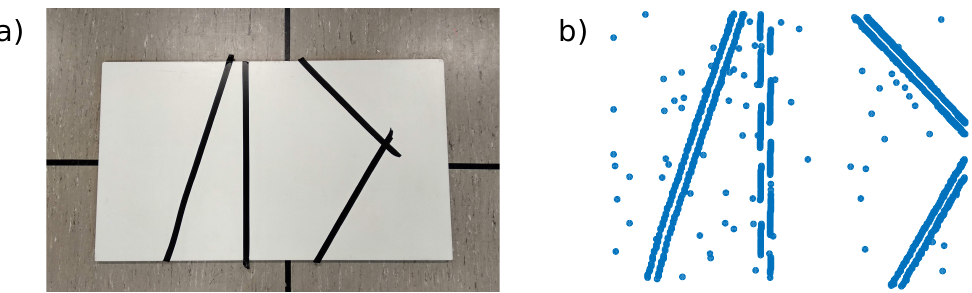
Figure 9. The scene used for the Lines test. ( a ) Frame capture of the scene consisting of various lines with few intersections. ( b ) The point cloud map generated at initialization with 1000 points in blue. The initial FoV was purposely did not contain any corners, and no new 3D points were added to the map during the test.